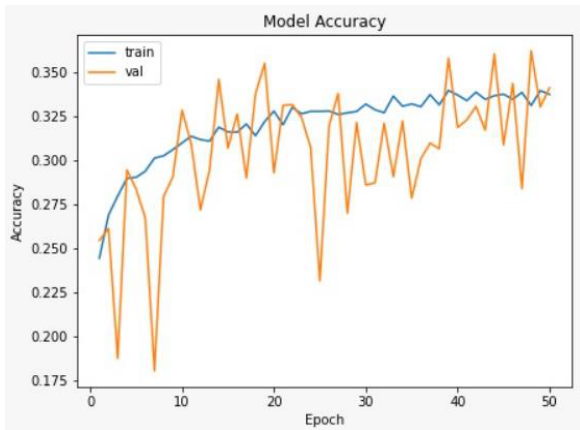
Fig. 4. Resnet50 model by Transfer Learning.